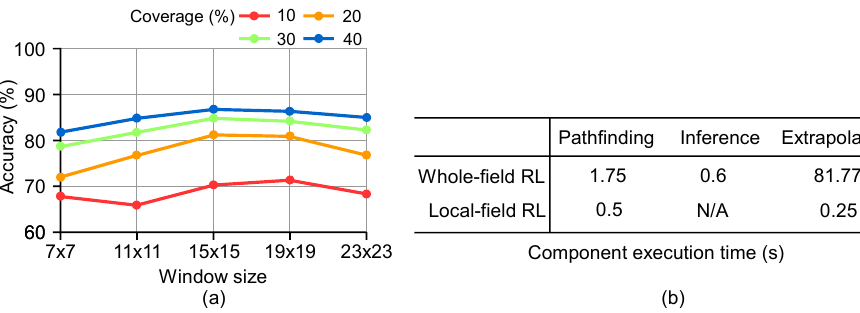
Figure 8. ( a ) The effects of prediction window size on final crop health map accuracy at different coverage rates for whole-field RL; and ( b ) the execution times of software components for local-field RL and whole-field RL with a window size of 15. [Note: Crop health map was generated